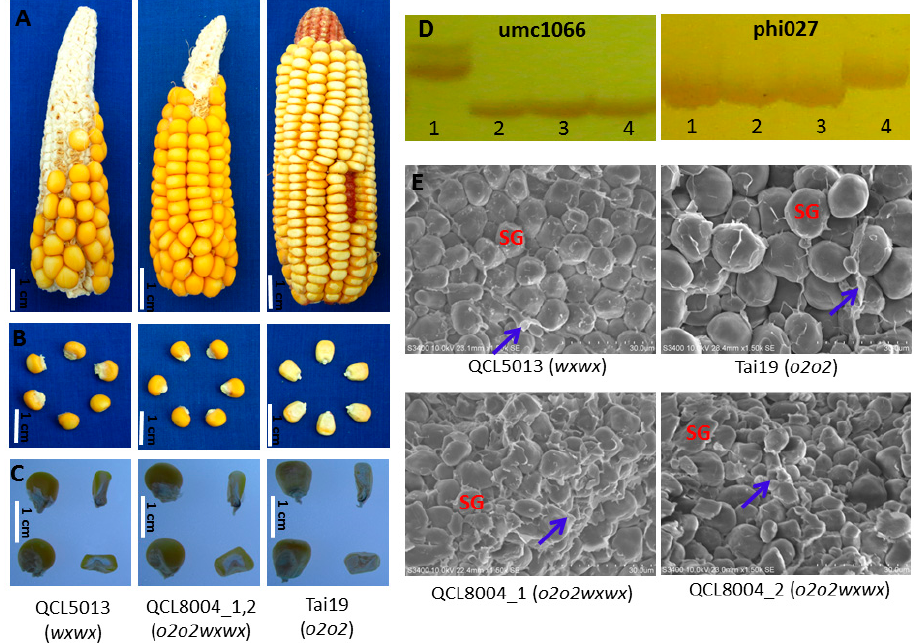
Figure 1. Phenotypic features of o2o2wxwx and recurrent parent. ( A ) Photographs of intact ears taken under normal light. ( B ) Photographs of mature kernels taken under normal light. ( C ) Light transmission of mature kernels on a light box, Bars = 1 cm. ( D ) Electrophoresis pattern of SSR marker for target gene o2 and wx . Lane 1, QCL5013; Lane 2, QCL8004_1; Lane 3, QCL8004_2; Lane 4, Tai19. ( E ) Scanning electron micrograph for endosperms of QCL8004_1, QCL8004_2, QCL5013, and Tai19 at 1500× magnification, respectively, Bars = 30 µm. SG, starch granules; Blue arrows, matrix protein. Table 1. The contents of lysine and amylopectin of QCL8004_1, QCL8004_2, Tai 19, and QCL5013. No.